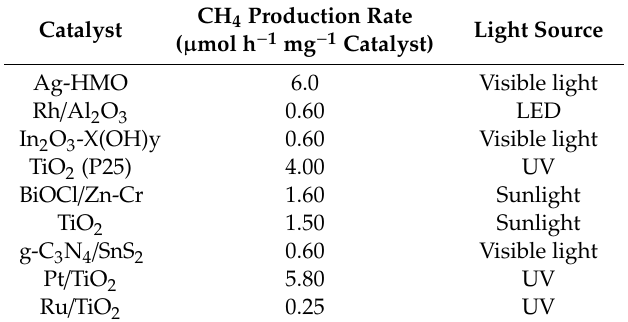
Table 1. Production rate for CH 4 via CO 2 reduction with H 2 over di ff erent photocatalysts under di ff erent light radiation. [Modified from Ref.